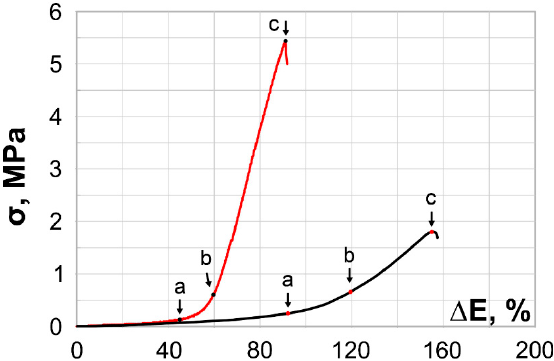
Figure 7. Stress/strain curves of tested rat aorta samples. Elastic limit ( A ), yield point ( B ) and ultimate stress point ( C ). Red curves reflect stress/strain plotting in the axial direction; black curves correspond to circumferential stretching.